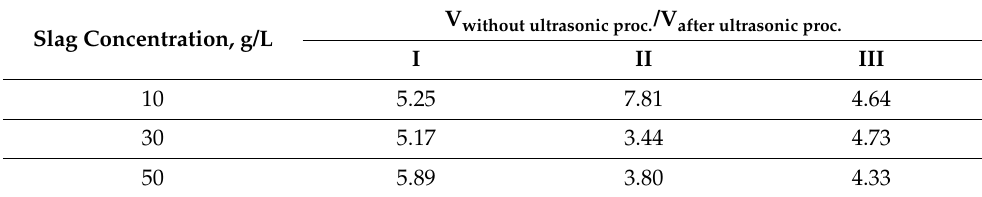
Table 14. Comparative analysis of the sedimentation rates of slag particles in a water-polymer suspension after and without ultrasonic processing. V without ultrasonic proc. /V after ultrasonic proc. Slag Concentration, g/L